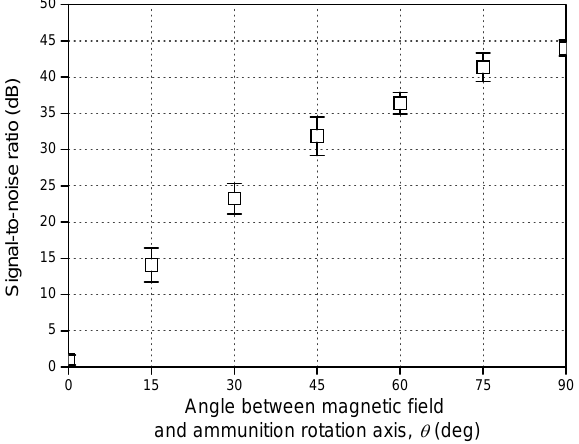
Figure 11. Measured SNR of MMIS as function of angle between magnetic field and ammunition rotation